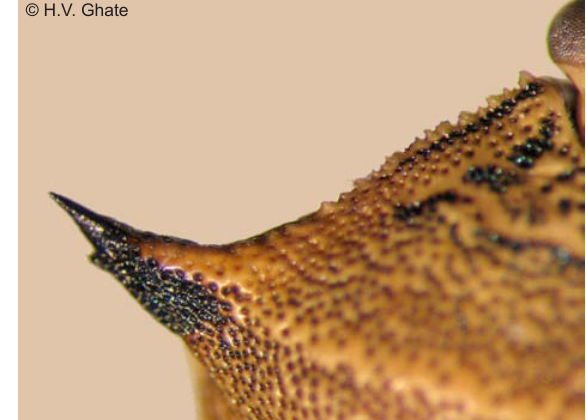
Image 3b. Andrallus spinidens : further close up of pronotum (dorsal view) showing lateral pronotal spine and coarse black punctures at its base along with short spine. Note also the crenulations of anterio-lateral